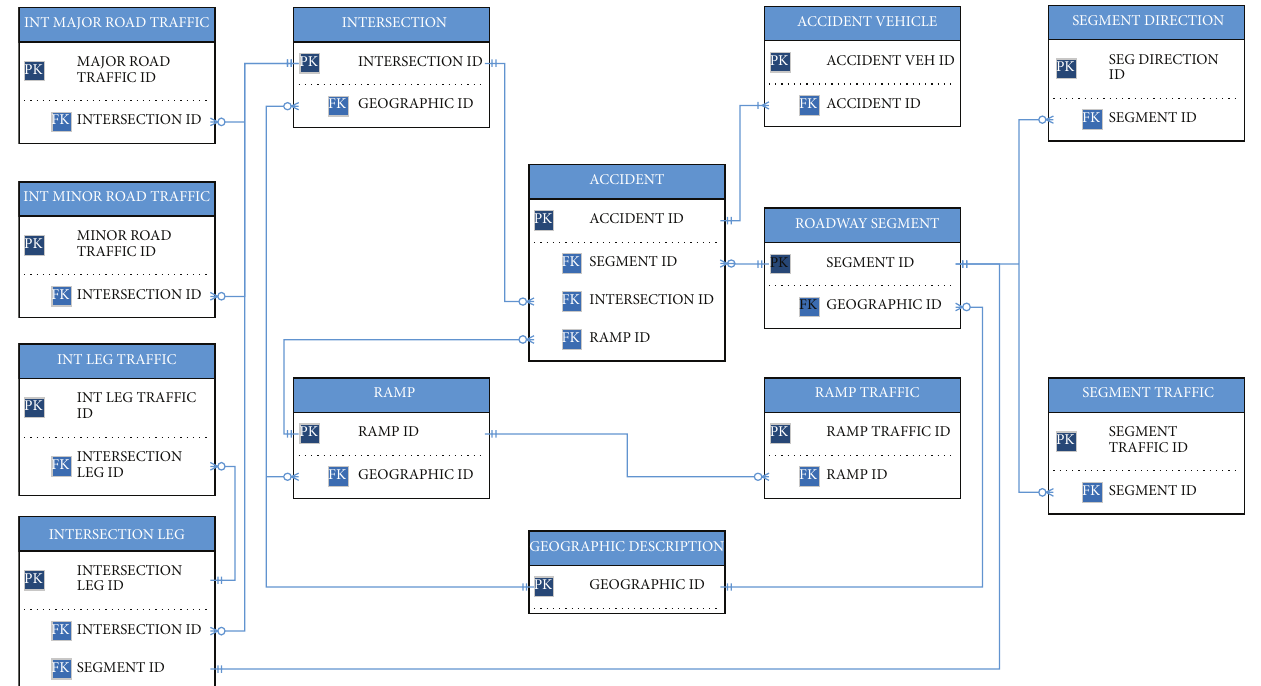
Figure 3: Entity relationship diagram for the proposed safety